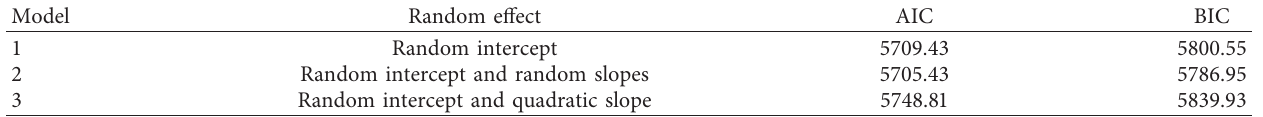
Table 2: Selection of random effect models to be included in the linear mixed-effect model.